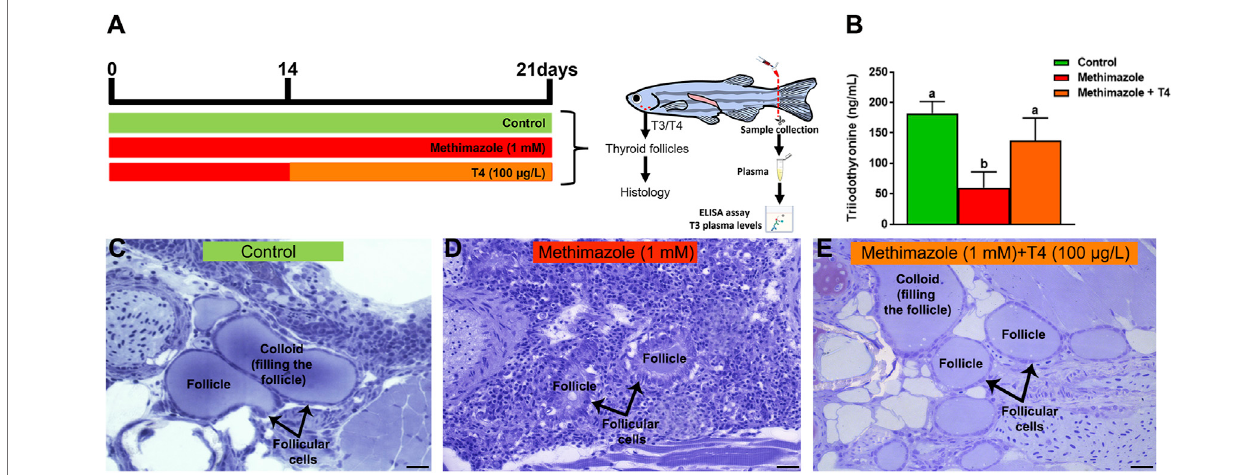
FIGURE 1 | (A) Experimental design representation of treatments: control (non-treated fi sh), methimazole (1 mM) and methimazole (1 mM) co-treated with T4 (100 μ g/L ) groups.Zebra fi shadultmaleswereexposedtoreconstitutedwatercontaining1 mMmethimazole(goitrogen) for21 days or1 mM methimazole followingT4 (100 μ g/L)addedinthewaterfromthesecondweekuntiltheendofexposure.Thecontrolgroupreceivedthesamevolumeofvehiclesolution.T3levels(ng/mLplasma) and thyroid follicles were evaluated after treatments. (B) Levels of Triiodothyronine (T3) in the plasma of adult male zebra fi sh following methimazole induced- hypothyroidism and methimazole co-treated with T4. Bars represent the mean ± SEM ( n = 5 per condition). ANOVA followed by Dunnett ’ s multiple comparison tests. Distinctlettersdenotesigni fi cantdifferences( p < 0.05)betweendifferenttreatmentconditionswiththecontrolgroup.After3 weeksheadsweredissectedforhistological analysis of thyroid follicles (C – E) . Control group (C) have thyroid follicles typical of euthyroid animals. These thyroid follicles display squamous or cuboidal epithelial cells and aretotally fi lledwithcolloid. However, animals treatedwithmethimazole (D) revealeddisturbedthyroidfollicles withcolumnar epithelium, folliclecell hypertrophy and colloid depletion, while fi sh co-treated with T4 (E) showed follicles similar to the control animals. Staining: Toluidine blue with sodium borate. Scale bar = 20 μ m.